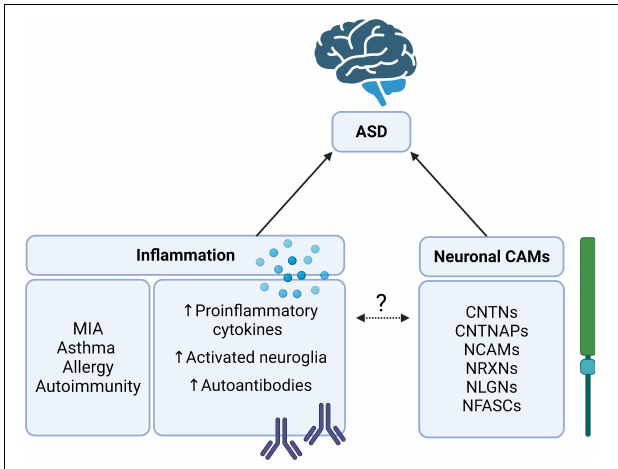
FIGURE 1 | The relationship between autism spectrum disorder (ASD), inflammation, and cell adhesion molecules (CAMs). Neuronal CAMs such as the CNTN, CNTNAP, NCAM, NRXN, NLGN, and NFASC families of proteins are consistently implicated as risk genes for ASD (9, 16). Likewise, inflammation, particularly in MIA, has been identified as an environmental risk factor for ASD (24, 31). What is yet unclear is whether these neuronal CAMs may be involved in regulating inflammatory responses or cascades in ASD. Contactin (CNTN), CNTN-associated protein (CNTNAP), neural cell adhesion molecule (NCAM), neurexin (NRXN), neuroligin (NLGN), neurofascin (NFASC), and maternal immune activation (MIA). Created with